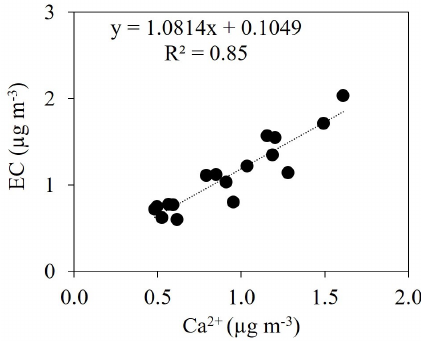
Figure 4. Relationship between PM 2 . 5 concentrations of Ca 2 + and EC (µgm − 3 ) during spring of